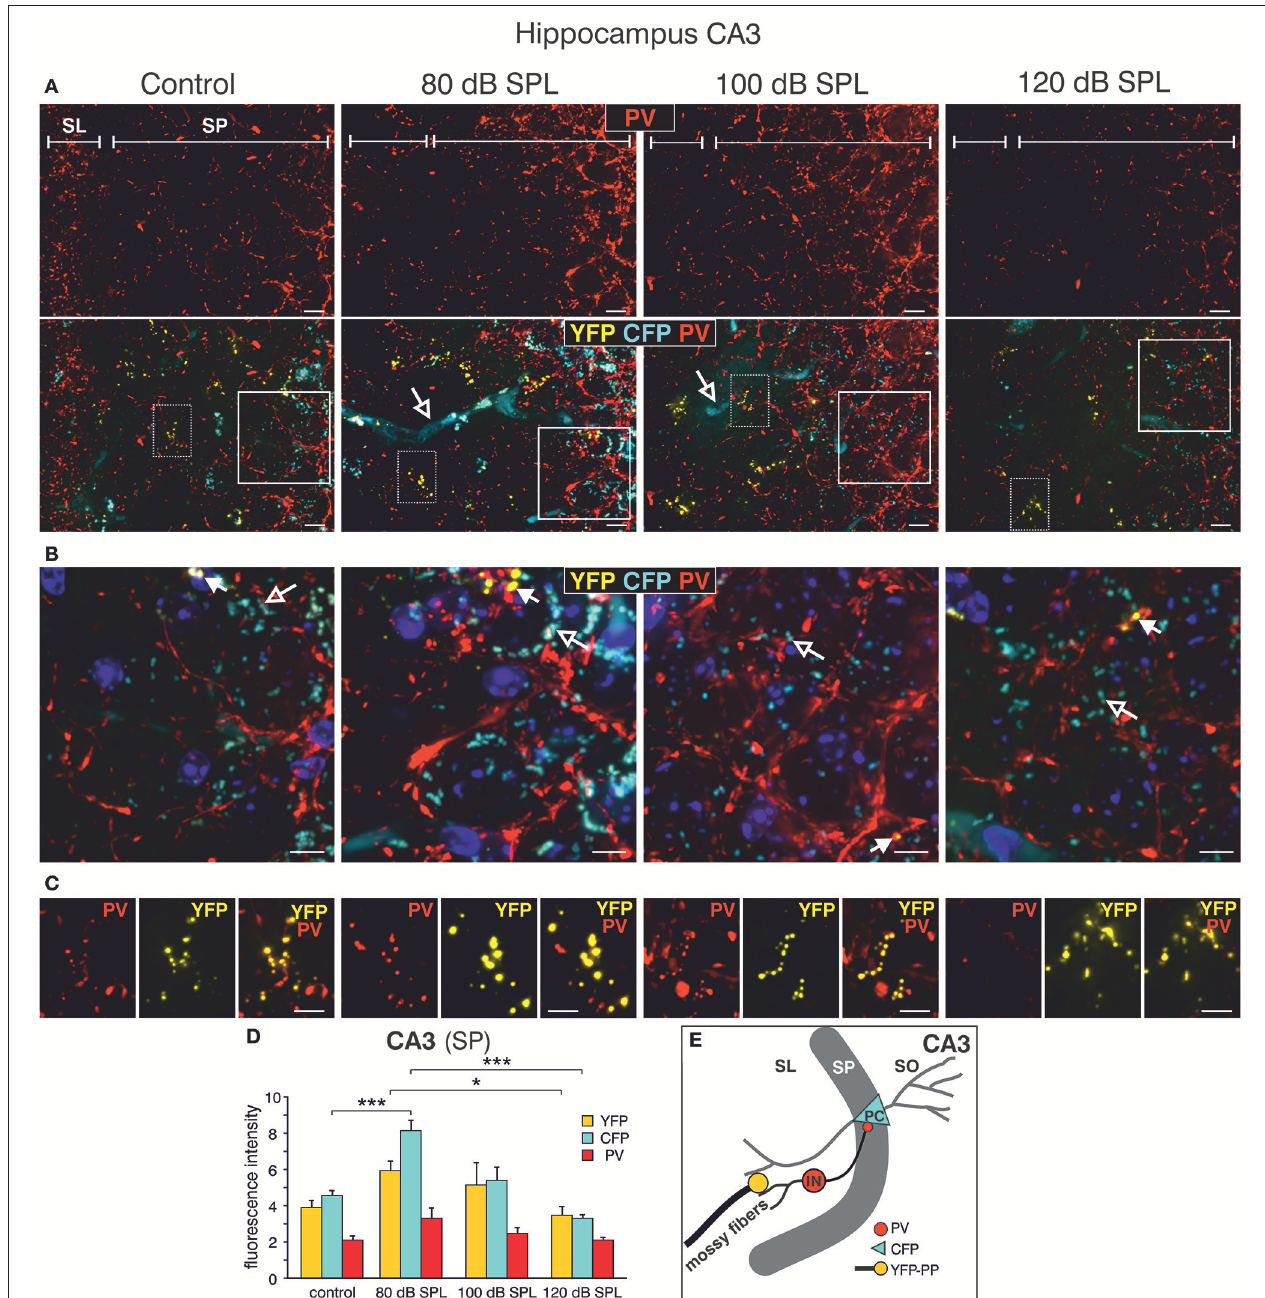
FIGURE 5 | Dynamic changes of Bdnf exon-IV and -VI transcripts and parvalbumin expression in the CA3 region following sound exposure. (A,B) Hippocampal CA3 region with magnification of the stratum lucidum (SL) and stratum pyramidale (SP). (A) Immunostaining of parvalbumin (PV, red). Note the difference in PV expression in the SP in dependence of the applied sound exposure. Scale bars: 10 µ m. Lower panel: Triple staining of the same CA3 region. Open arrows indicate Bdnf exon-IV-CFP in blood vessels. Scale bars: 10 µ m. (B) Magnified view from solid frame in (A) . CFP (open arrows) and PV (red) expression at the level of the SP. Closed arrows indicate Bdnf exon-VI-YFP. Nuclei stained with DAPI (blues). Scale bars: 5 µ m. (C) Magnified view from dashed frame in (A) . Bdnf exon-VI-positive-YFP expression in mossy fiber terminals contacts overlaps with PV-positive (red) interneurons in the SL region of the CA3 and increases (80 dB SPL) or declines (120 dB SPL) with sound. Scale bars: 5 µ m. (A–C) n = 6 animals/group. (D) Quantification of CFP, YFP, and PV fluorescence averaged over the SL and SP region of the CA3 region. Bdnf exon-IV-CFP fluorescence intensity peaks in animals subjected to 80 dB SPL. Bdnf exon-VI-YFP and Bdnf exon-IV-CFP after 80 dB SPL sound exposure were also significantly elevated when compared to 120 dB SPL-exposed animals. Data represented as mean ± SD. (E) Model depicting assumed locations of altered CFP, YFP, and PV expression after 80 dB SPL sound exposure. Mossy fiber terminals (yellow) terminate on dendrites of excitatory CA3 pyramidal cells (PC) and PV-positive inhibitory interneuron (IN, red). CFP is found in the perisomatic areas of CA3 PCs (blue). SO, stratum oriens.